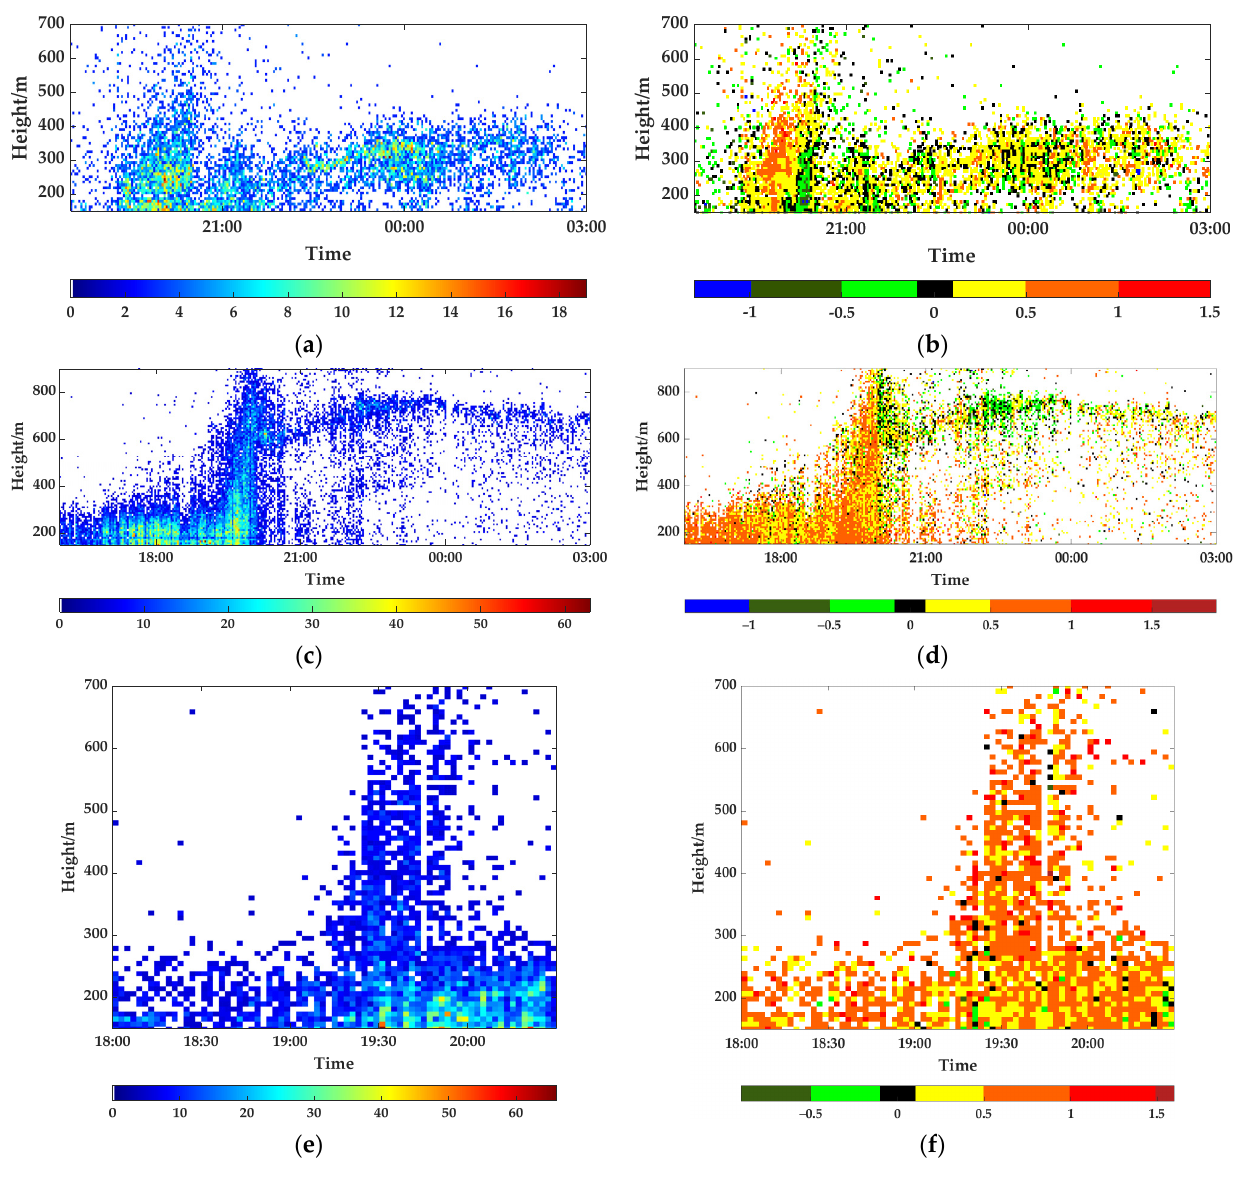
Figure 18. Relationships between the number and the ascent/descent rates with the height and time for the insects with typical taking-off behavior: ( a , b ) number and ascent/descent rate distribution with height and time observed on 25–26 July 2020 (sunset occurred at 20:04 h); ( c , d ) number and ascent/descent rate distribution with height and time observed on 24–25 March 2021 (sunset occurred at 19:25 h); ( e , f ) number and ascent/descent rate distribution with height and time observed on 5 March 2021 (sunset occurred at 19:17 h).